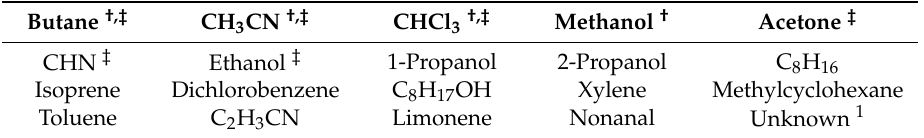
Table 1. Selected volatile organic compounds (VOCs) for the computer-assisted diagnostic analysis.